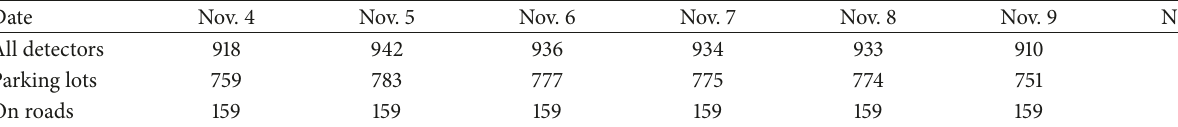
Table 2: Amount of detection ID for each day.